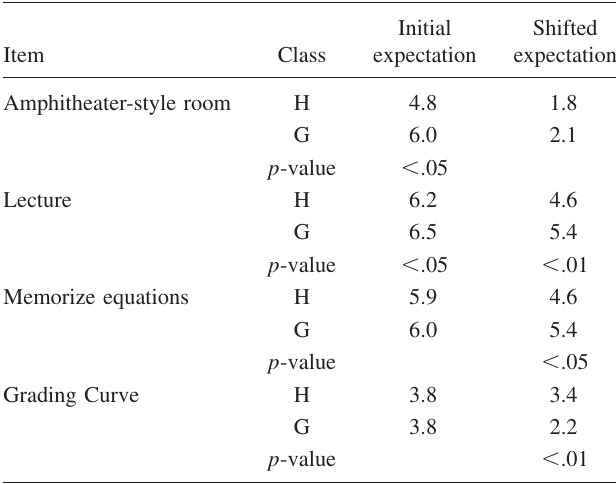
TABLE VII. Differences in expectations at ODU.